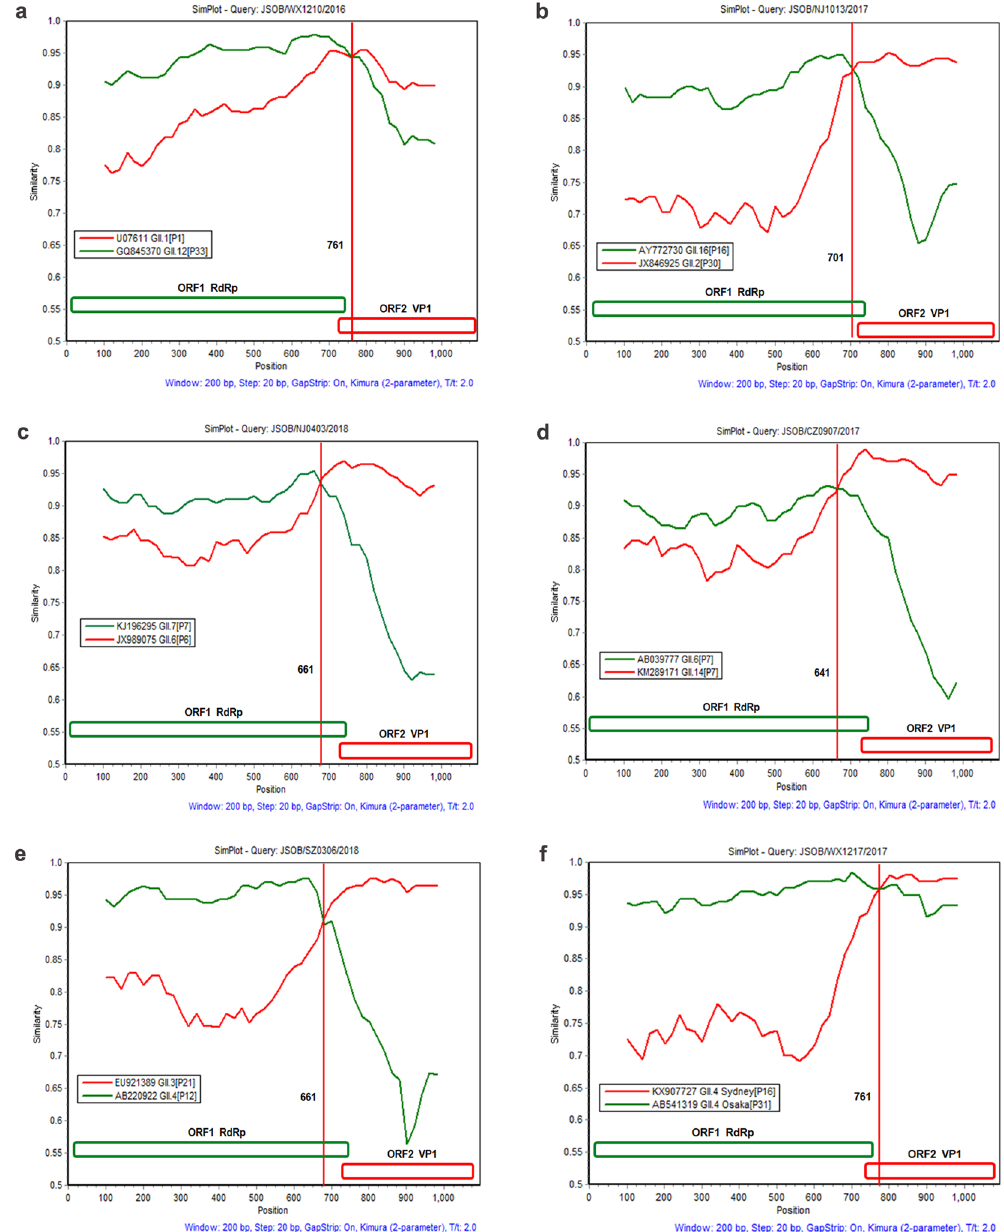
Figure 4. The SimPlot analysis of the recombinant strain sequences. SimPlot was constructed using a Simplot software version 3.5 with a slide window width of 200 bp and a step size of 20 bp. At each position of the window, the query sequence was compared to each of the reference strains. The X-axis indicates the nucleotide positions in the multiple alignments of the NoV sequences; and the Y-axis indicates nucleotide identities (%) between the query sequence and the NoV reference